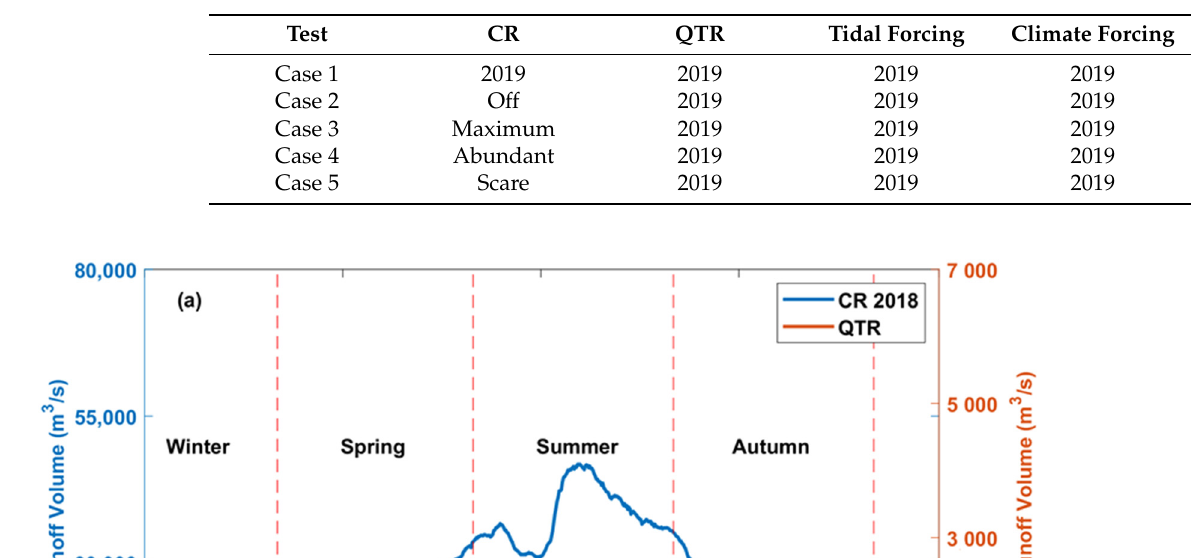
Table 4. Descriptions of numerical tests.